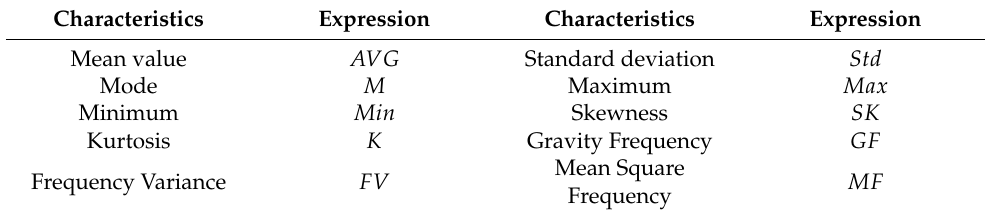
Table 1. Initial feature set of activity